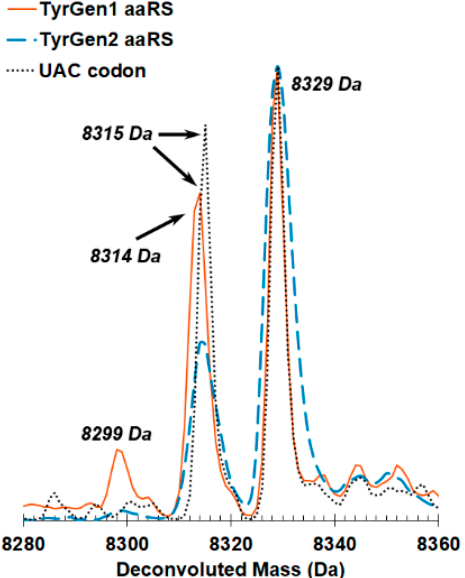
Figure 2. ESI-MS of purified Z domain proteins for identification of amino acids incorporated by evolved M. barkeri Pyl aminoacyl tRNA synthetases. Protein was translated via decoding a UAG amber stop codon (TyrGen1 aaRS: orange, solid line. TyrGen2 aaRS, blue, dashed line) or decoding a UAC Tyr codon (grey, dotted line). The calculated mass of the Z domain protein with tyrosine at position 5 is 8315 Da. This peak is observed in all three samples analyzed. A second +14 Da peak is also observed and likely corresponds to methylation of the Z domain. A second parent peak at 8299 Da in the mass spectrum of the full-length Z domain produced with the TyrGen1 aaRS suggests a small amount of phenylalanine incorporation. The observation of a broadened peak at 8314 Da and 8315 Da in this spectrum only is indicative of methylated Phe-incorporated Z domain (8314 Da) and non-methylated Tyr-incorporated Z domain (8315 Da). The second parent peak at 8299 Da is absent from the mass spectrum of the full-length Z domain produced after expression of the TyrGen2 aaRS, suggesting improved substrate specificity for